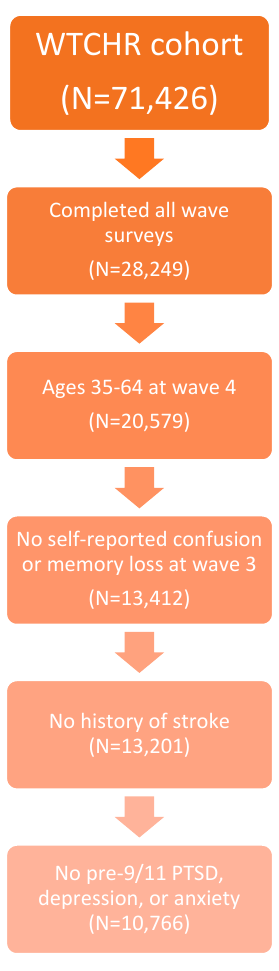
Figure 1. Development of the study sample.